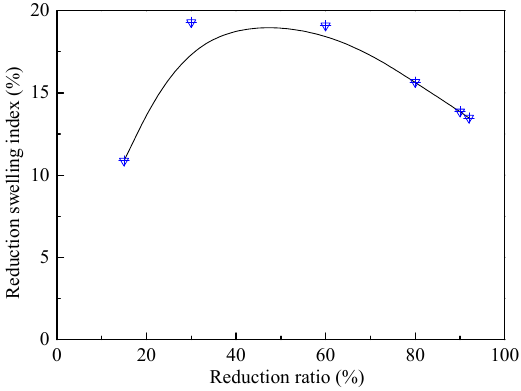
Figure 14. Changes in the reduction swelling index (RSI) with the increasing reduction ratio.